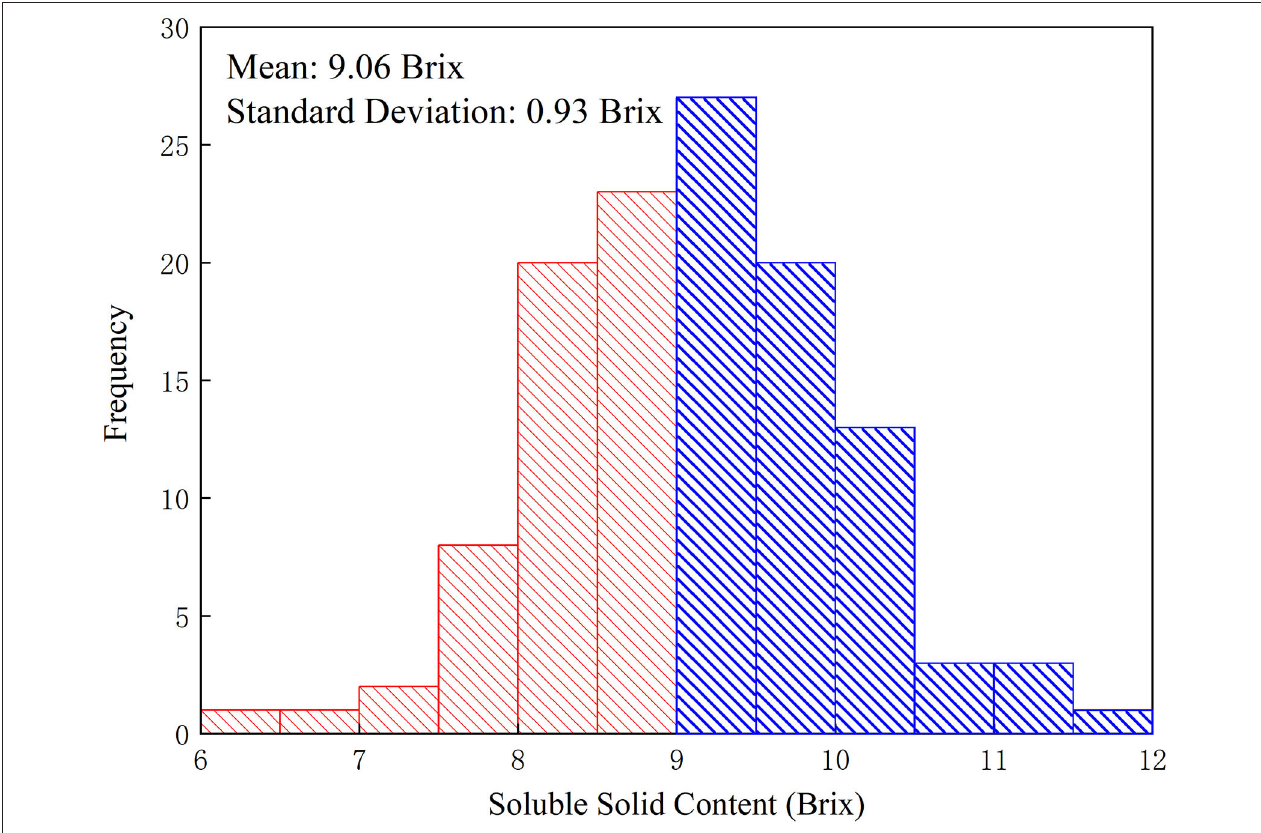
FIGURE 3 | Histogram of citrus soluble solid content (SSC) of the total 122 fruit samples collected in this study. The mean of all citruses’ SSC is 9.06 Brix while the SD is 0.93 Brix. The citruses corresponding to the blue areas are regarded as sweet while the citruses corresponding to the red ones are regarded as